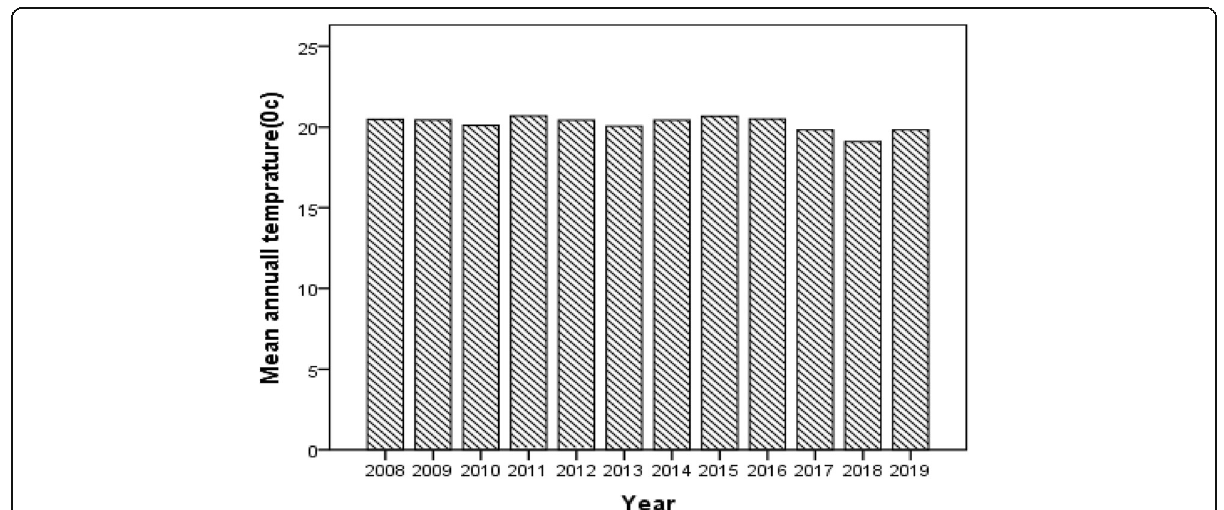
Fig. 4 Mean annual temperatures recorded (2008 – 2019) at the region weather station (source: data from the National Meteorological Service Agency of